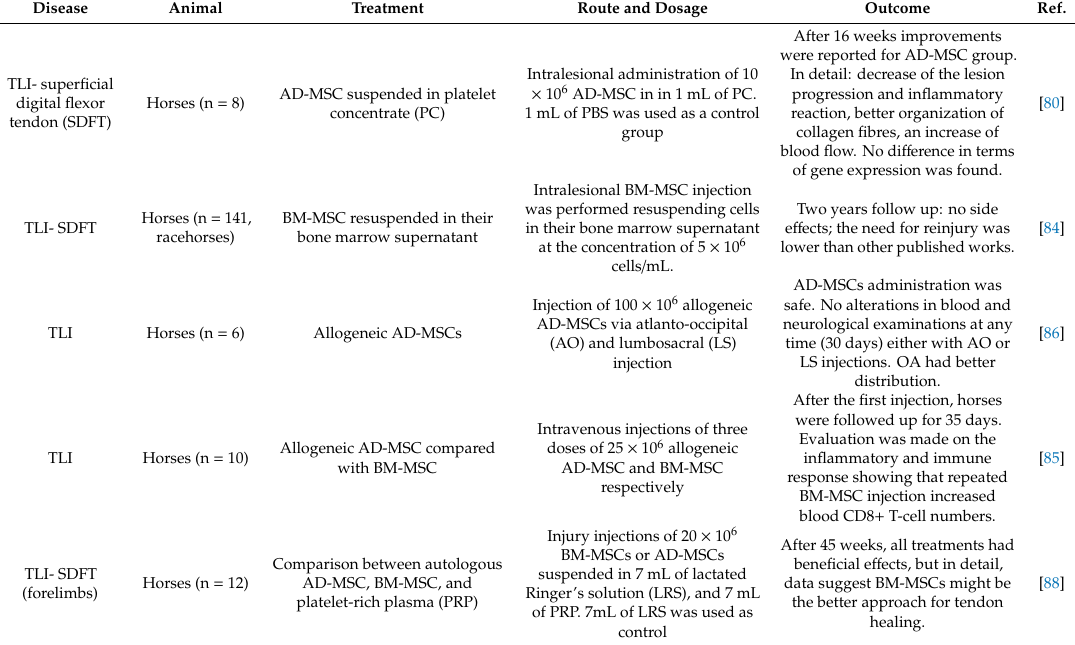
Table 3. Summary of tendon ligament injury (TLI) disease treated with MSCs. Disease